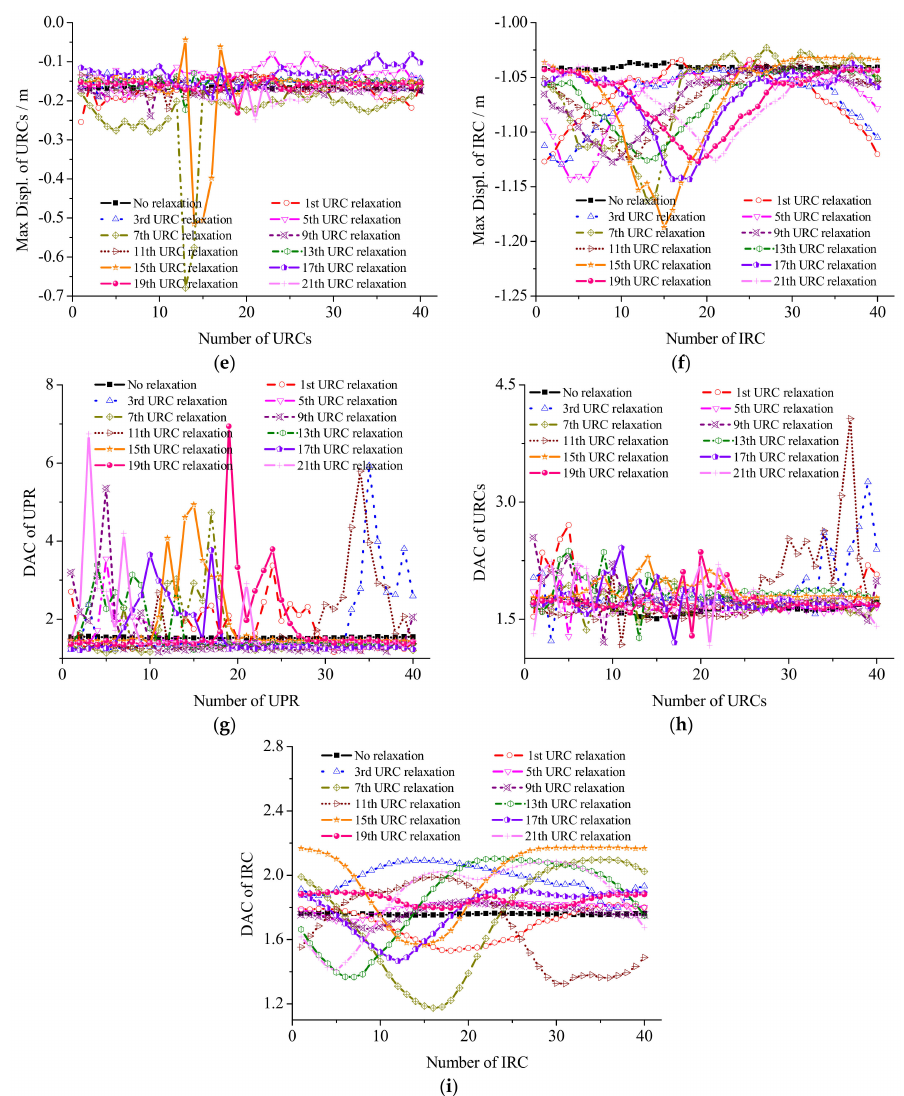
Figure 11. Response distributions of the structure for the di ff erent URC relaxations. ( a ) Axial stress of UPR; ( b ) Axial stress of URCs; ( c ) Axial stress of IRC ( d ) Displ. of Z direction of UPR; ( e ) Displ. of Z direction of URCs; ( f ) Displac. of Z direction of IRC; ( g ) DAC of UPR; ( h ) DAC of URCs; ( i ) DAC of